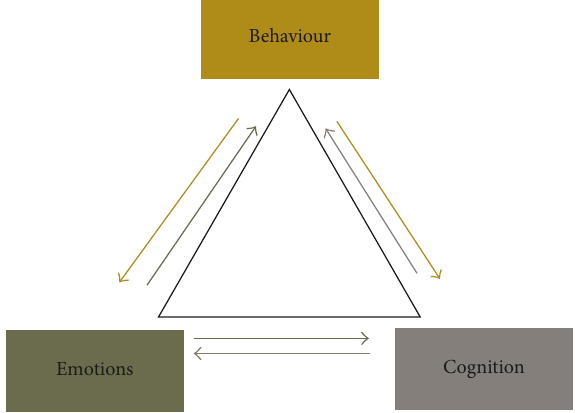
Figure 2: The interrelationship between emotion, behaviour, and